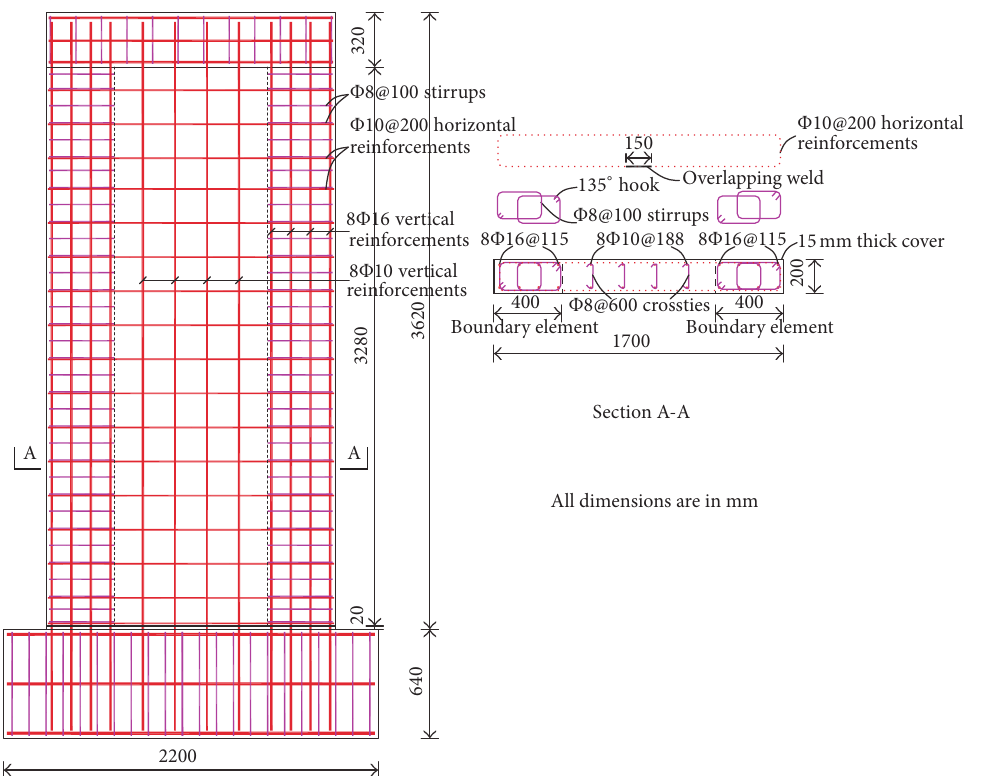
Figure 2: Details of the monolithic wall